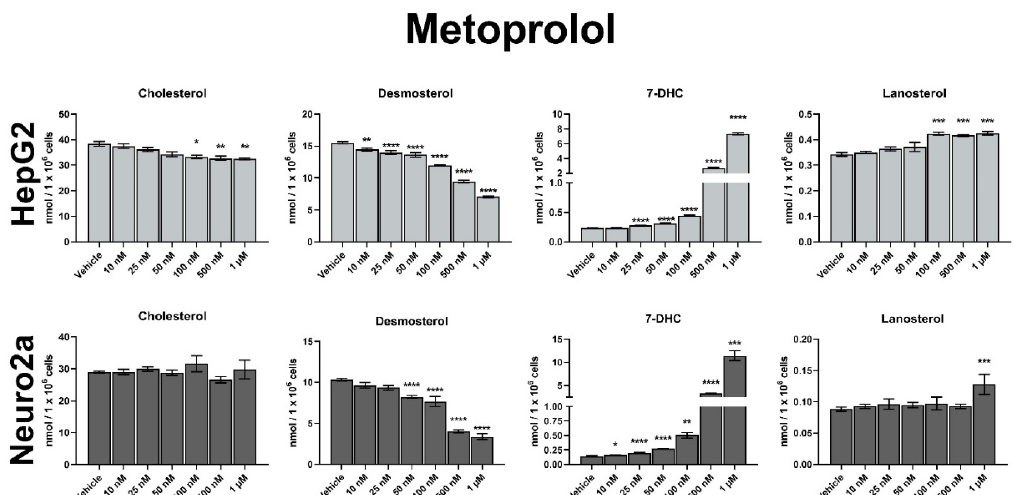
Figure 3. Dose-dependent sterol response of neurons and astrocytes treated with MTP. Values reported as nmol/million cells. Note the broken y -axis for 7-DHC. Statistical significance: * p < 0.05; ** p < 0.01; *** p < 0.001; **** p < 0.0001 vs. vehicle treatment.